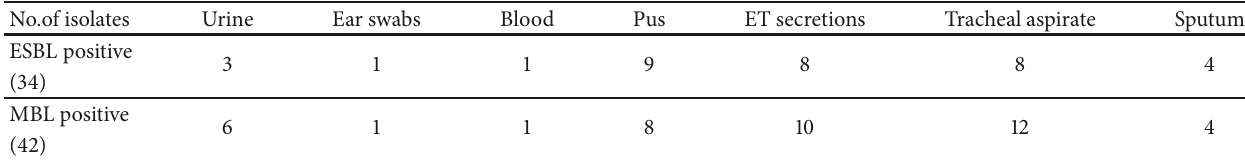
Table 3: Sample-wise distribution of ESBL and MBL isolates of P. aeruginosa